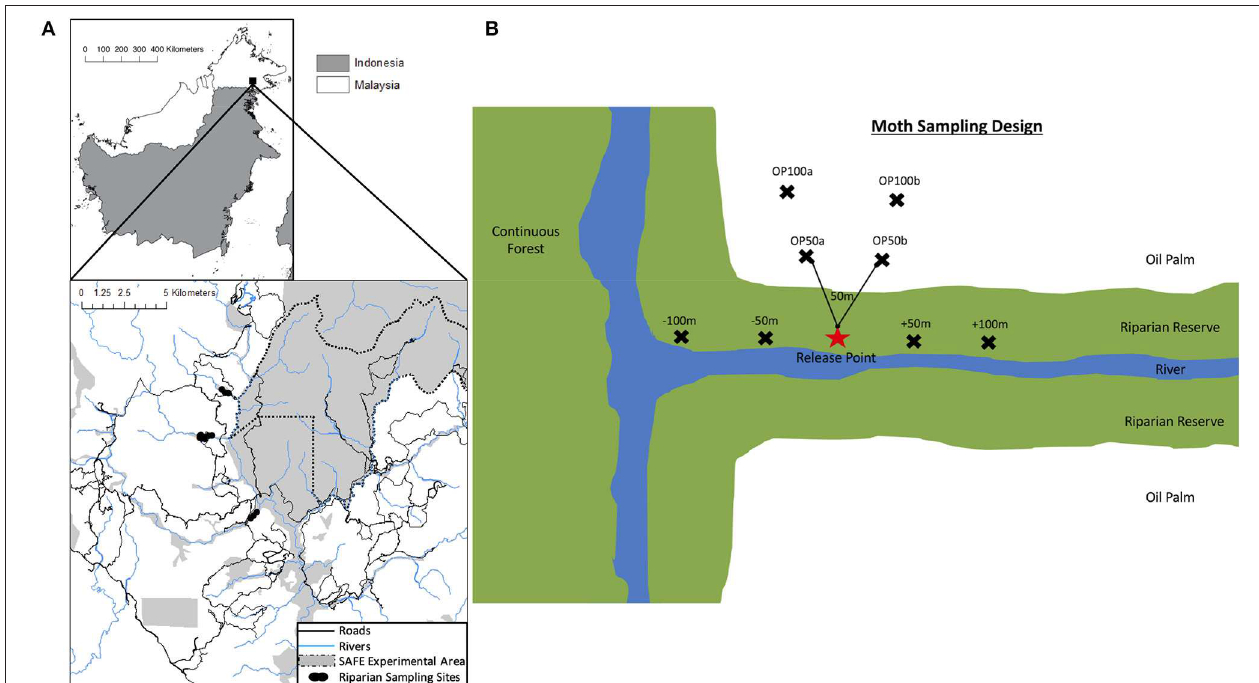
FIGURE 1 | (A) The upper panel highlights the location of the study area in Sabah, Northern Borneo. The lower panel displays a map of riparian reserve sites used in this study. The map is adapted from Gray et al. (2014). Black dots represent the riparian sampling sites labeled RR18, RR3 and RR10 from top to bottom. The dotted black line shows the SAFE project experimental boundary. The solid gray shaded area in the top panel is the remaining logged forest, blue lines indicate rivers, and the white area indicates the matrix of oil palm plantations. (B) Schematic representation of the general sampling design in each riparian reserve for the mark-release-recapture study for moths. Black crosses indicate trapping points which were spaced by at least 50m. Lines on the diagram are to indicate spacing and are not drawn to scale. The star indicates the release point of marked